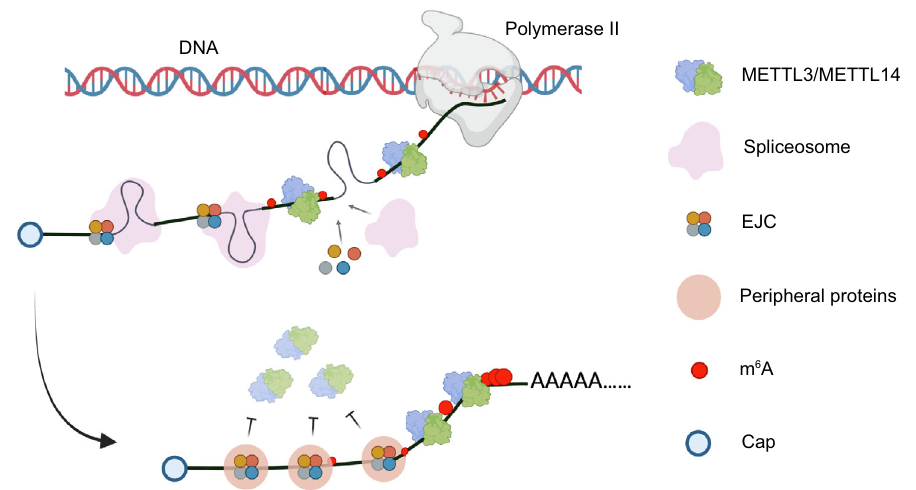
Fig. 5 | Blockade of METTL3 by the exon junction complex shapes the m 6 A epitranscriptome. Model for how the EJC locally controls METTL3-mediated m 6 A modi fi cation during mRNA processing. Created with